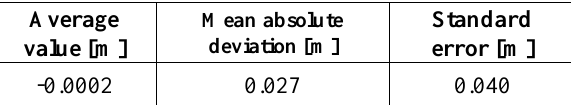
Table 5. Accuracy